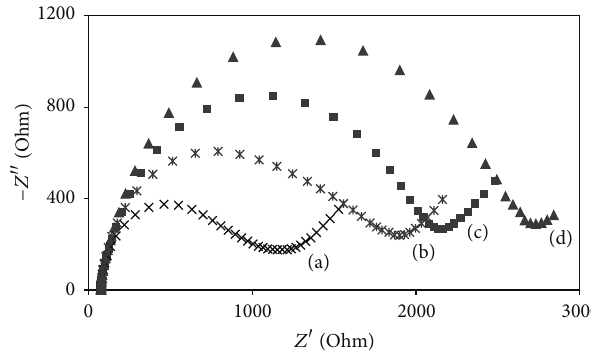
Figure 3: Nyquist diagram for the EIS measurements in 10mM [Fe(CN) 6 ] 3/4− in PBS (pH 7.4) at +0.13V bias potential for the bare graphite SPE (a); after the Ab1 immobilization (b); the immunore- actions with MUC1 protein and Ab2 (c); the binding to HRP-labeled Ab3 (d).